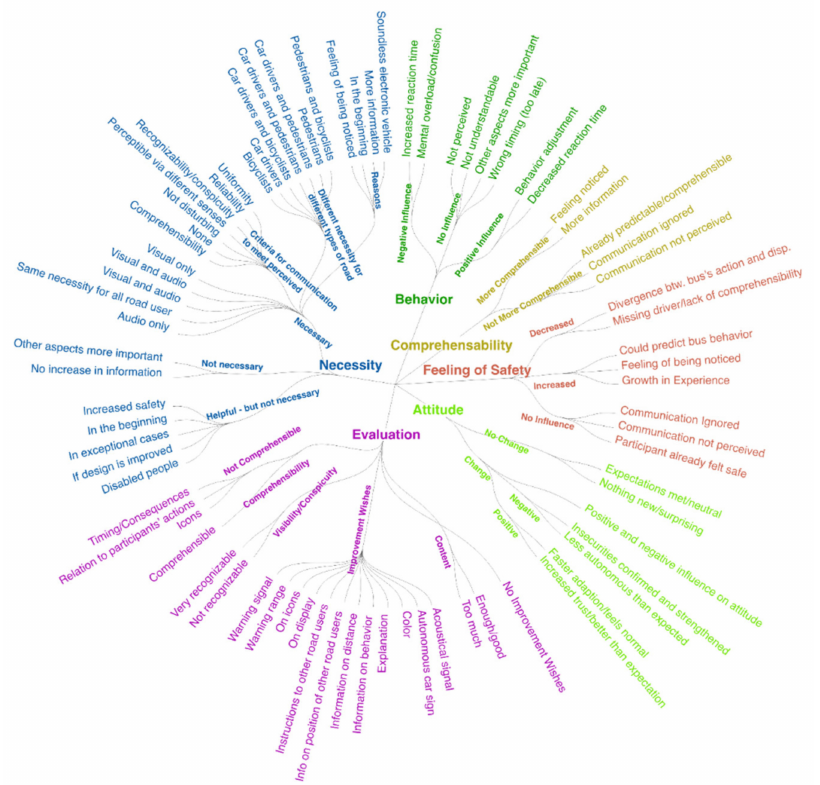
Figure 4. Final encoding system used for the qualitative content analysis of the